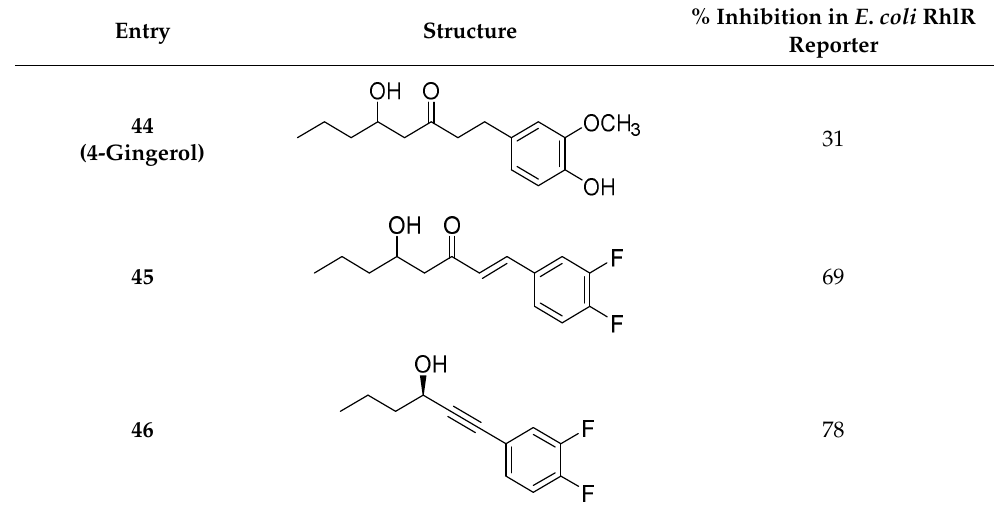
Table 6. Gingerol-based RhlR antagonists.